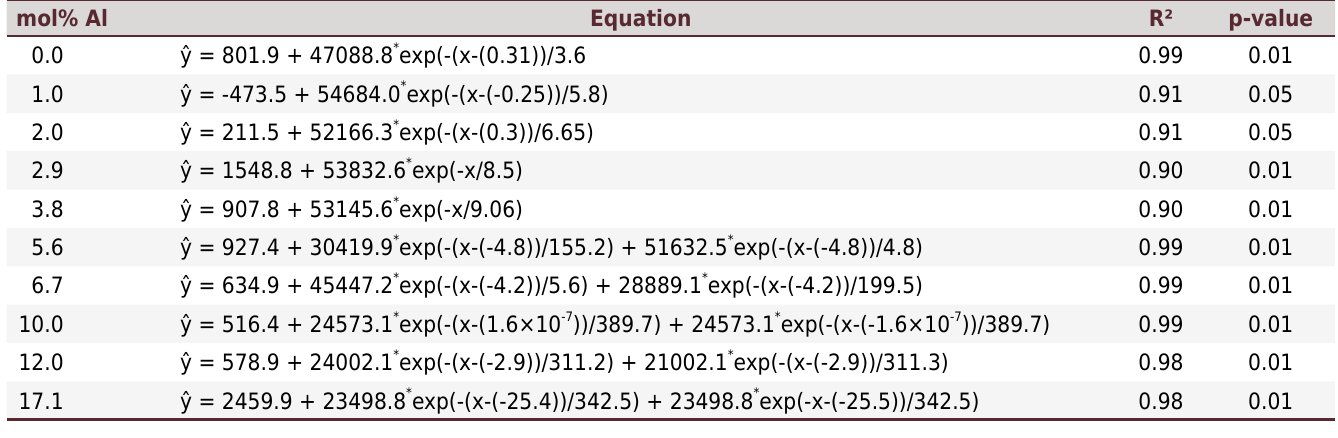
Table 1. Fitting of equations for the mass specific magnetic susceptibility ( LF ) values for synthetic Al-substituted maghemites subjected to different heating times at 500 °C